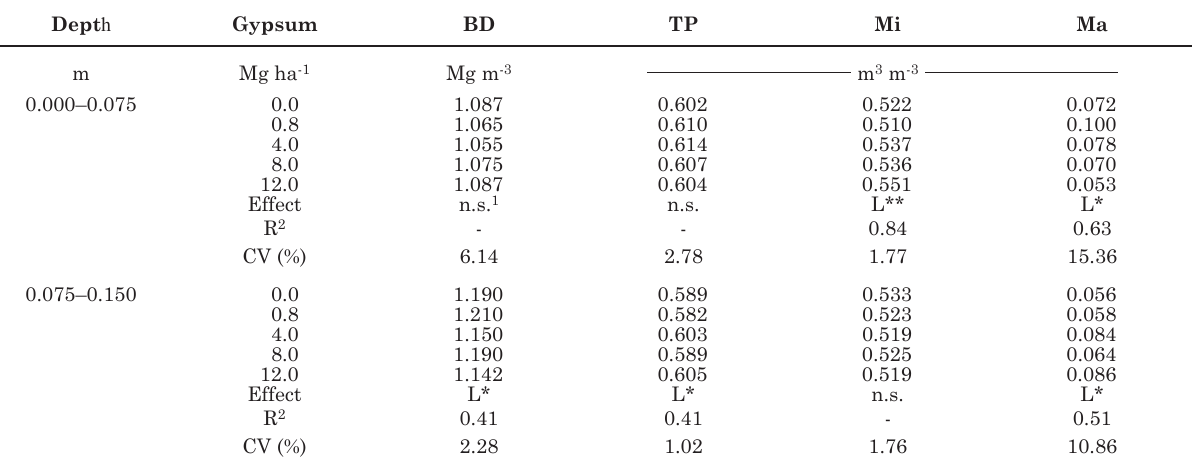
table 2. Soil bulk density (Bd), total soil porosity (tp), microporosity (Mi) and macroporosity (Ma) in different layers of a red latosol under no-tillage, 50 months after application of gypsum rates on the soil surface (guarapuava,